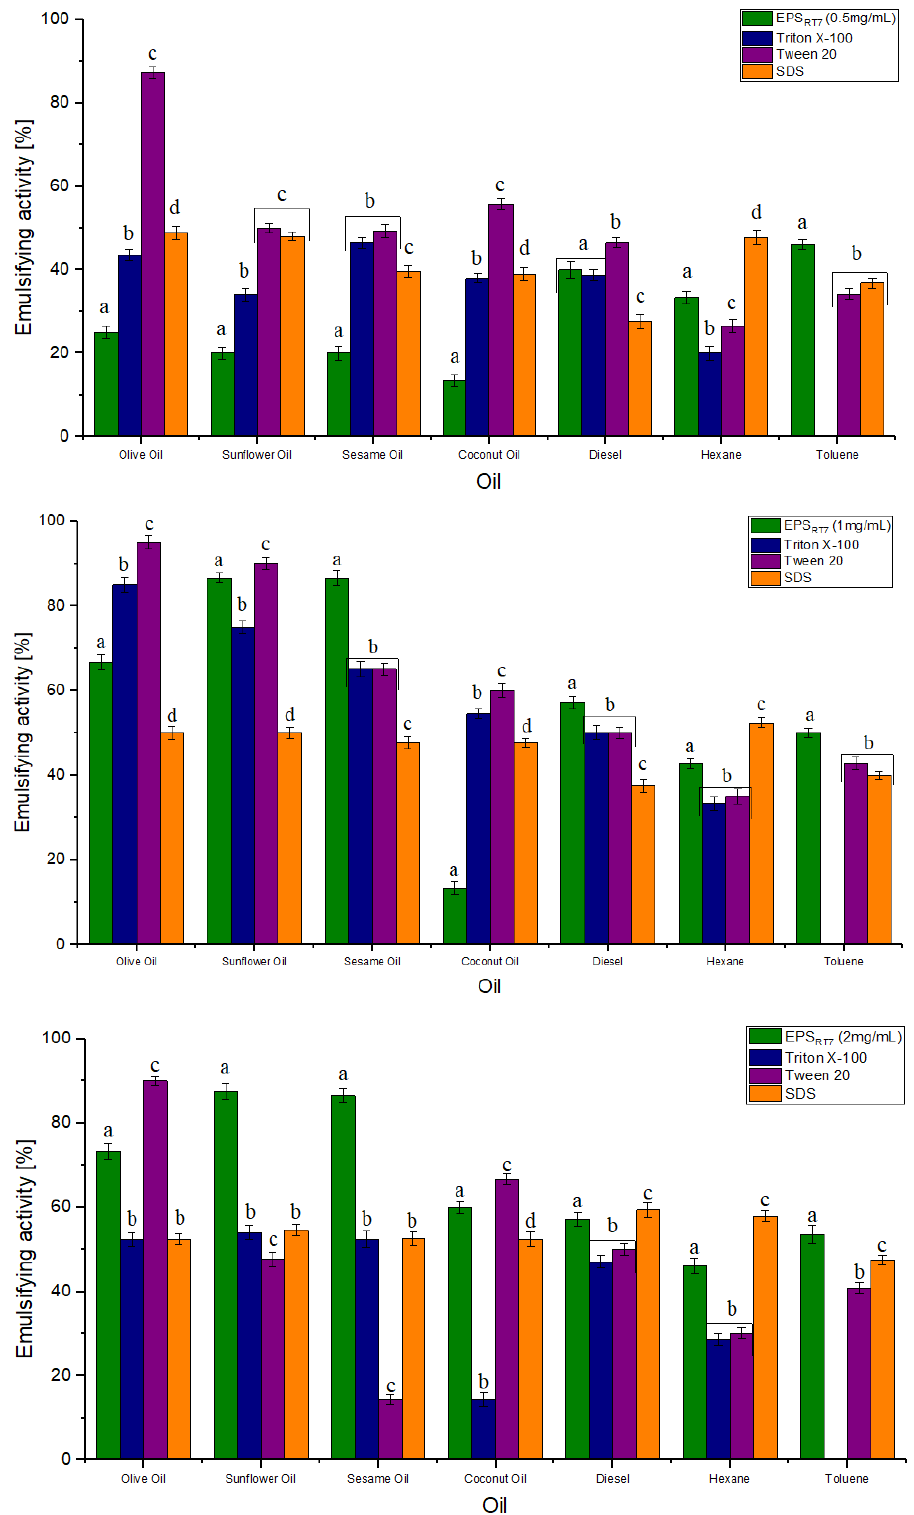
Figure 6. Comparison of emulsifying activity at different EPS RT7 concentrations (0.5, 1, 2 mg/mL) against commercial emulsifiers (Triton X-100, Tween 20 and SDS) across different natural oils and hydrocarbons. Different letters (a–d) represent the statistical difference between different emulsifiers for each natural oils and hydrocarbons ( p <